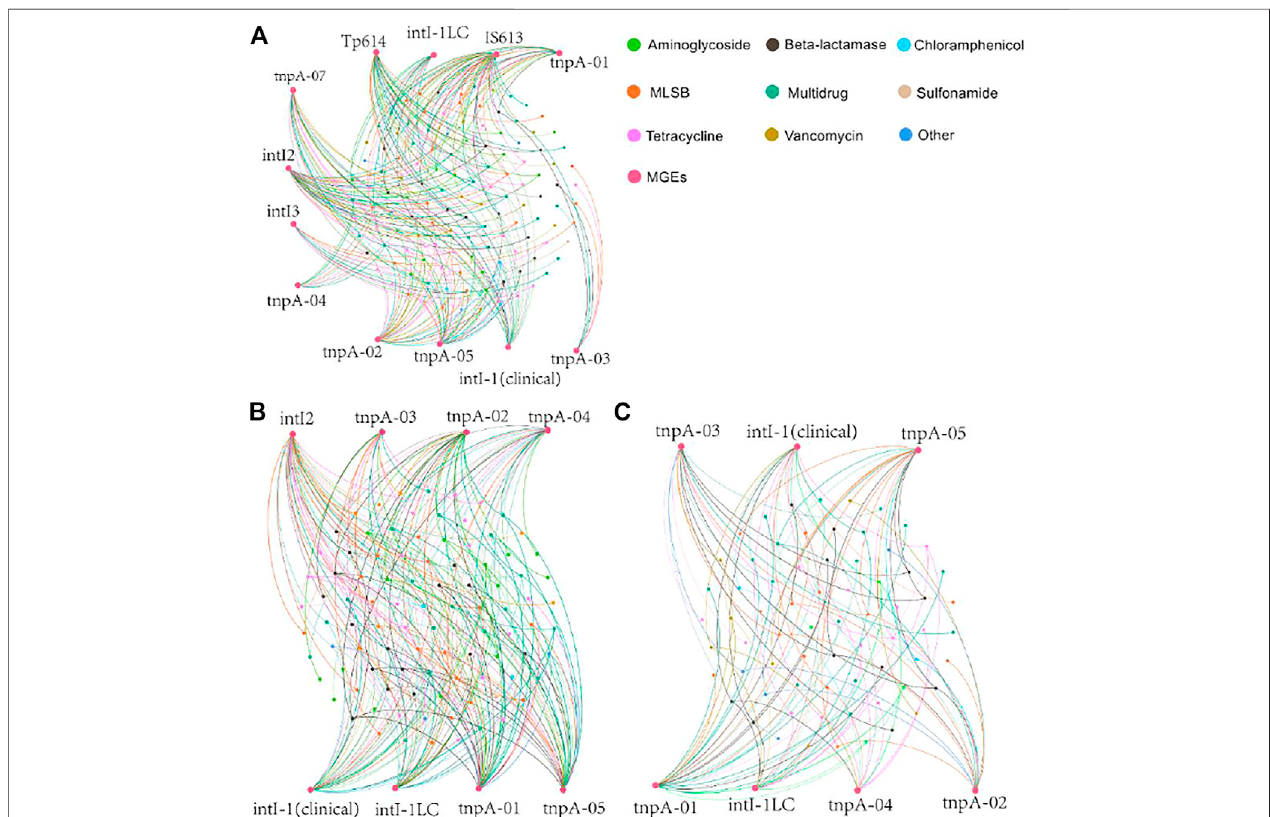
FIGURE4| NetworkanalysisdepictingthecorrelationsamongARGsandMGEsofstrawberriescollectedfromthe fi eldswithlong-termuseofrawpoultrymanure (PM) (A) , aerobic composting poultry manure (APM) (B) , and anaerobic composting poultry manure (AAPM) (C) . Each signi fi cant Spearman ’ s correlation ( p < 0.05) is presented by a connection line. Co-occurrence patterns among antibiotic resistome and